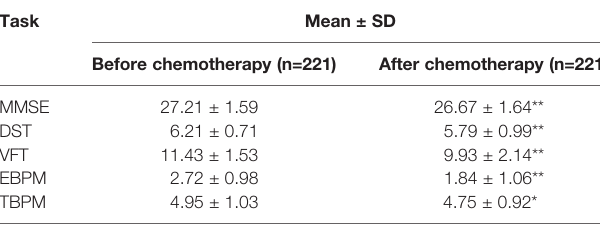
TABLE 2 | General assessment of cognitive before and after chemotherapy.